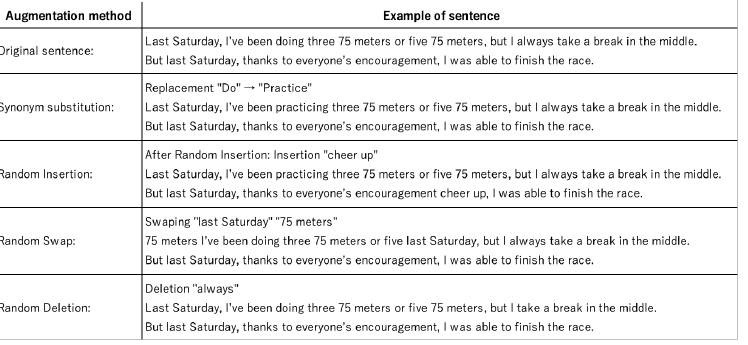
Figure 2. Original sentences in the dataset and sentences after using each of the EDA methods.